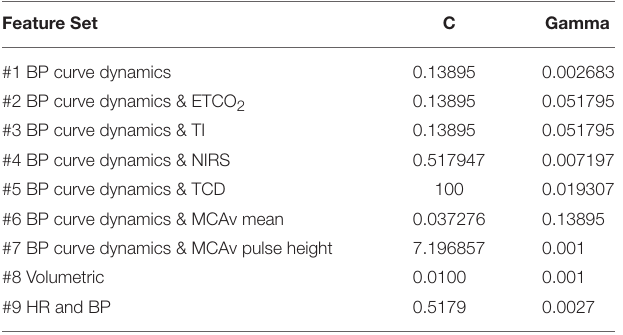
TABLE 2 | Optimal model configuration.